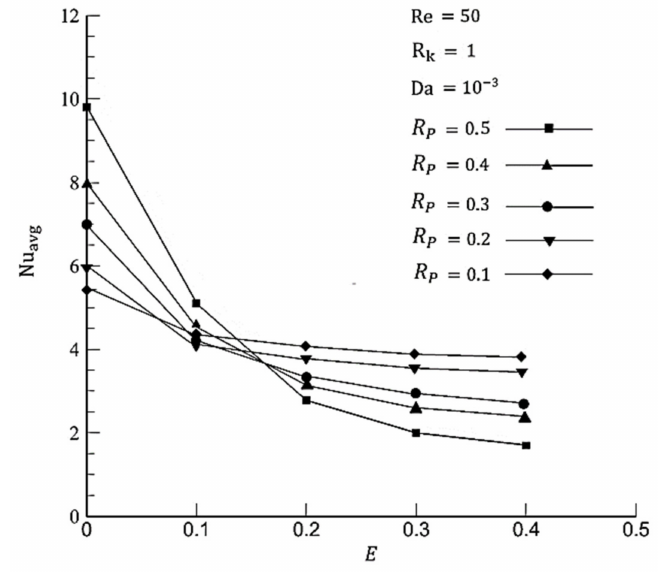
Figure 20. Effect of eccentricity on average Nusselt number in several porous